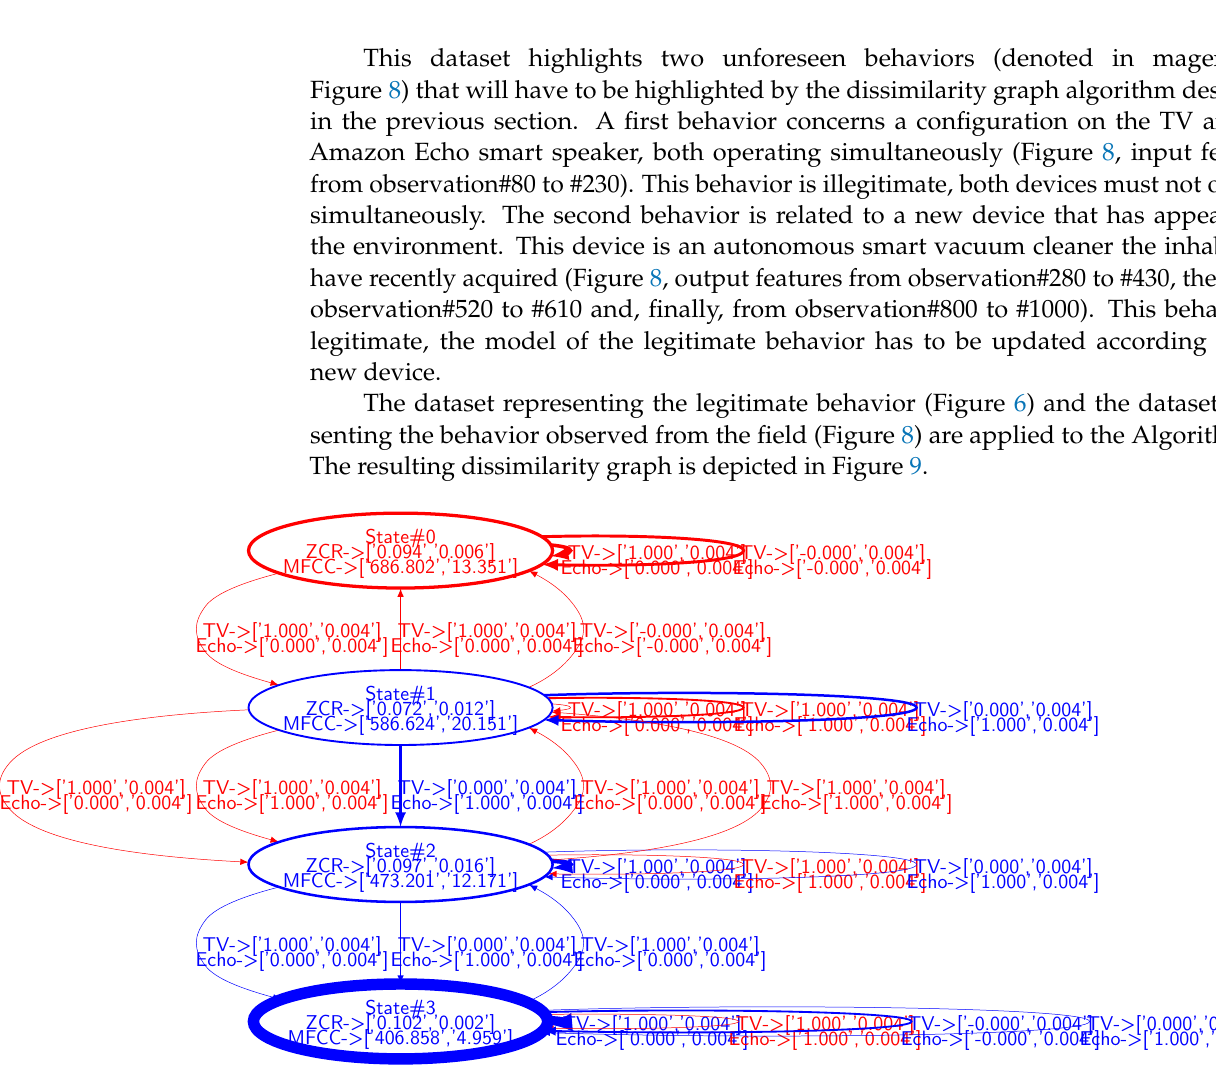
Figure 9. Dissimilarity graph between the legitimate behavior whose model is depicted in Figure 7 and the behavior observed from field observations, depicted in Figure 8. States and state transitions colored in red denote differences between both models ( min_samples =